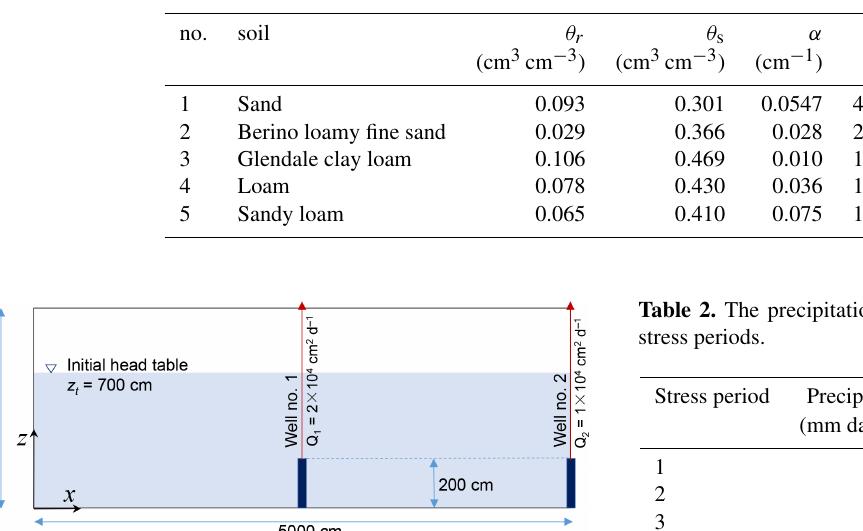
Table 1. Soil parameters used in the test cases.